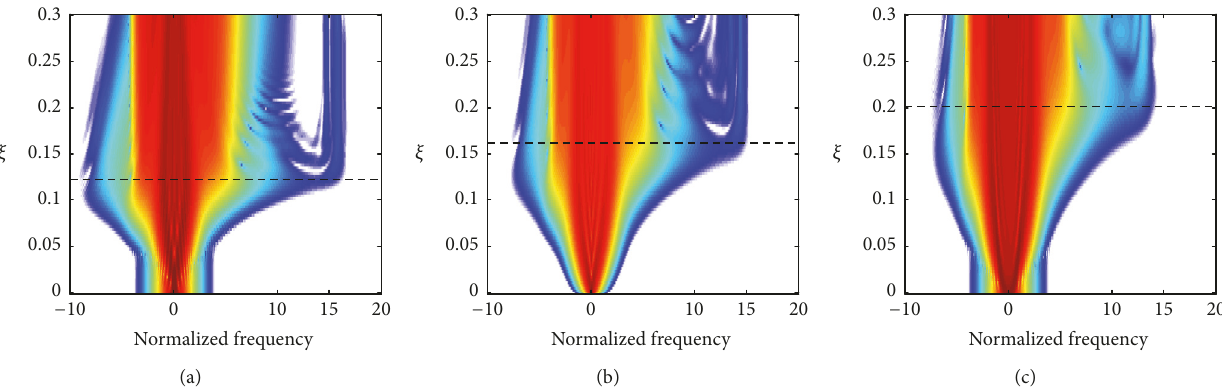
Figure 7: Density plots of spectral evolution during propagation for different input pulse chirps, (a) 𝐶 = −2 , (b) 𝐶 = 0 , and (c) 𝐶 = 2 when the sign of TOD is negative. The black horizontal dash line indicates the position at which the maximum spectral broadening occurs, that is, the DW generated.